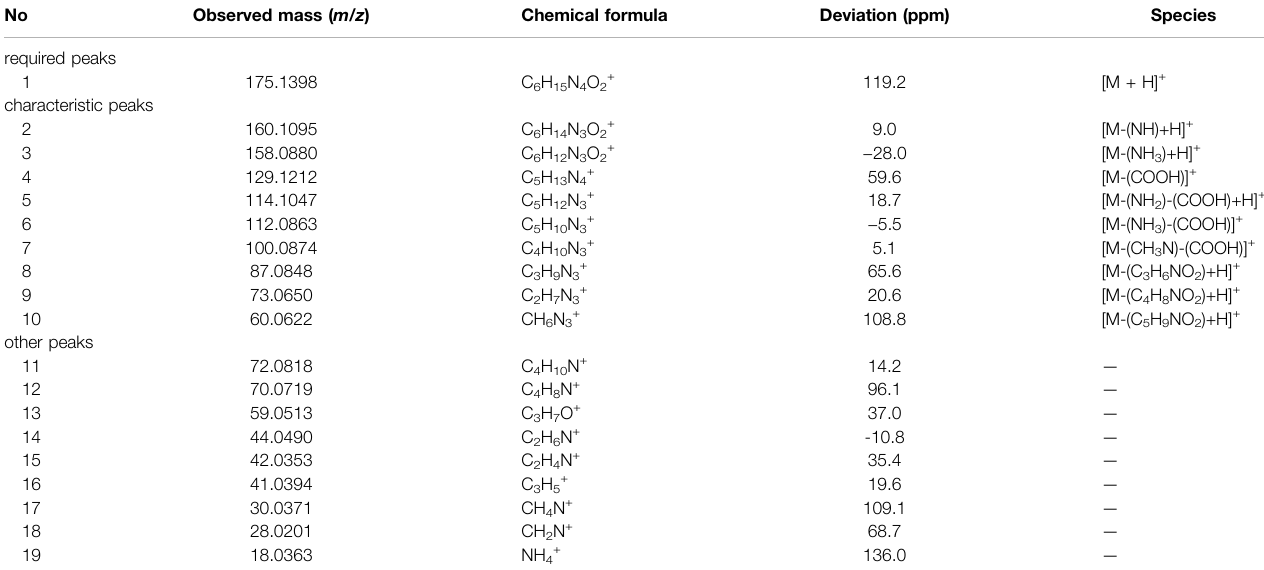
TABLE 1 | The peak assignments of arginine standard in TOF-SIMS spectra in the positive